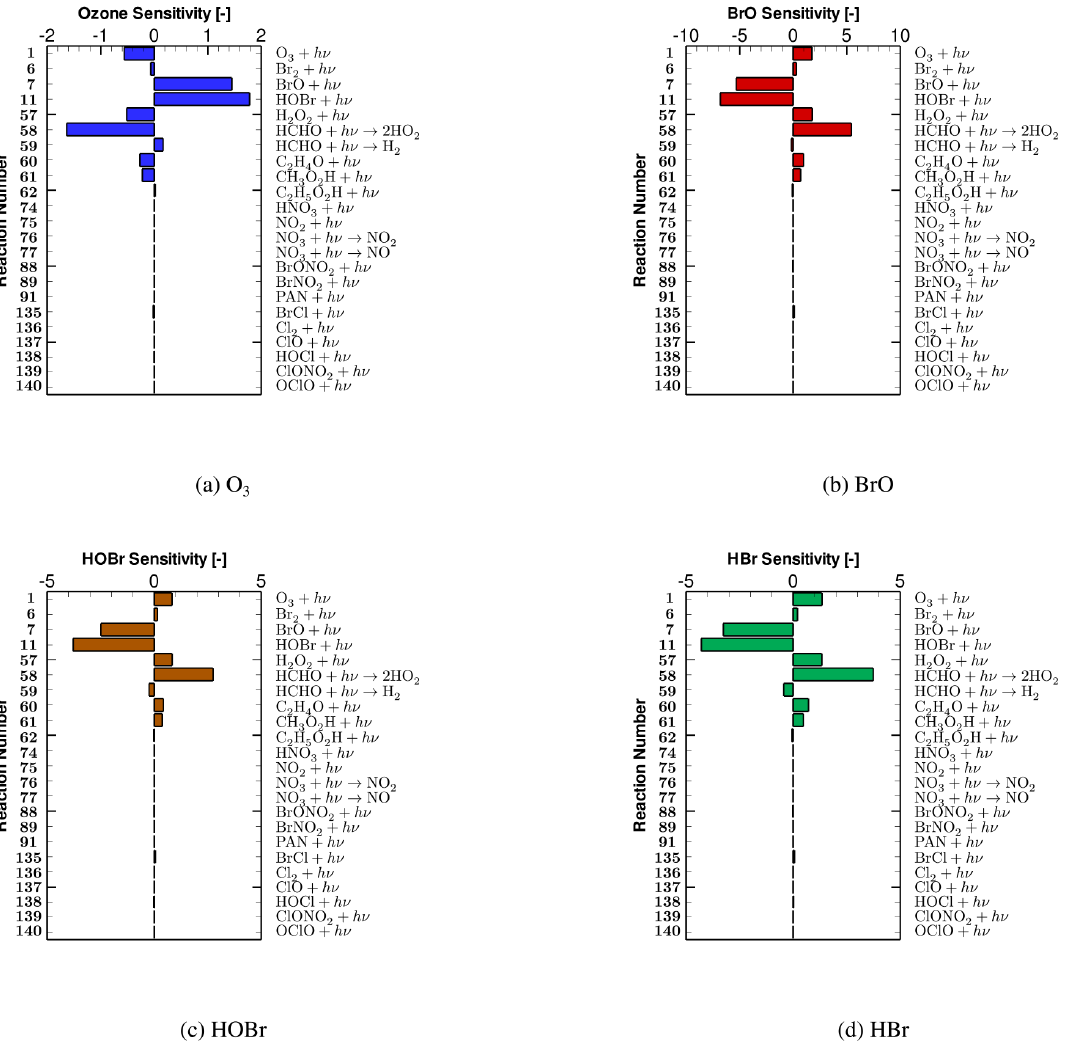
Figure 6. Relative sensitivities of (a) tropospheric ozone, (b) BrO, (c) HOBr and (d) HBr to photolysis reactions on day 5.8, which resides in the time period when the strongest ozone depletion